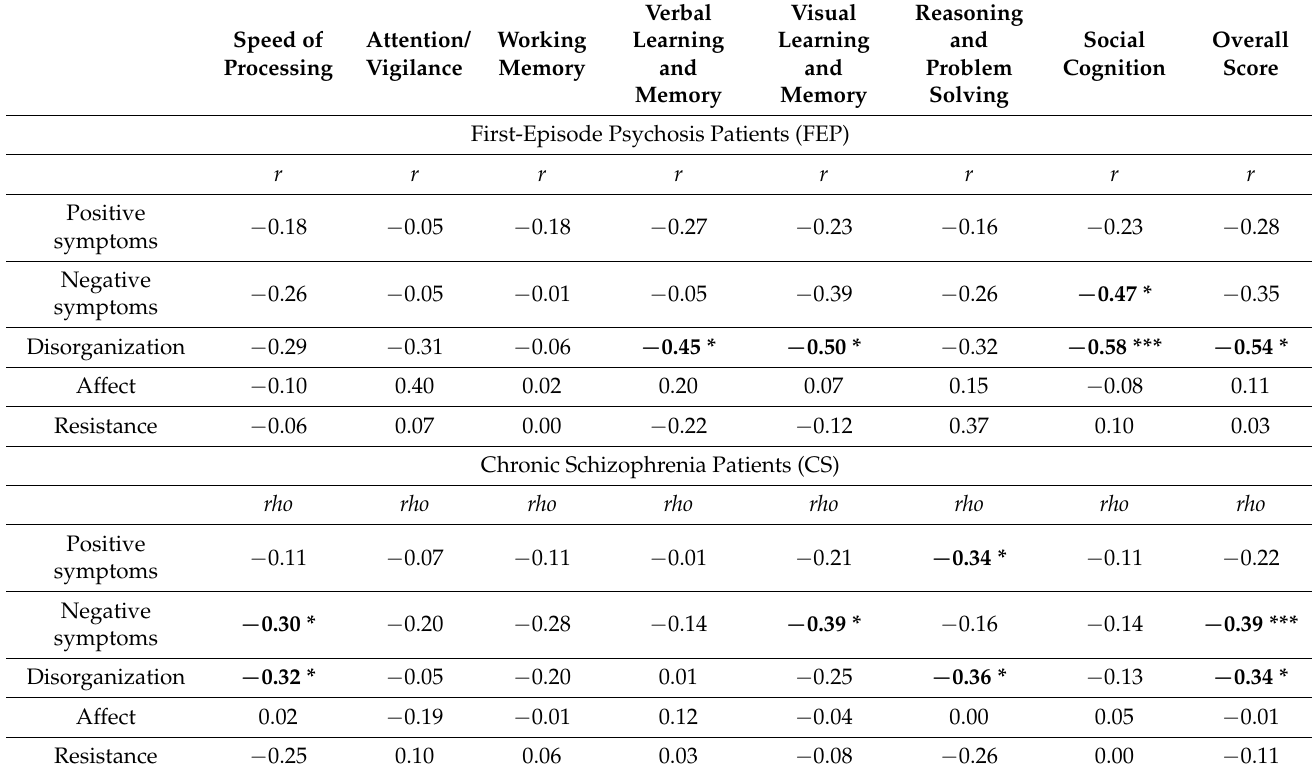
Table 4. Relationship between psychopathological dimensions assessed by PANSS and cognitive domains measured by MMCB battery in two clinical